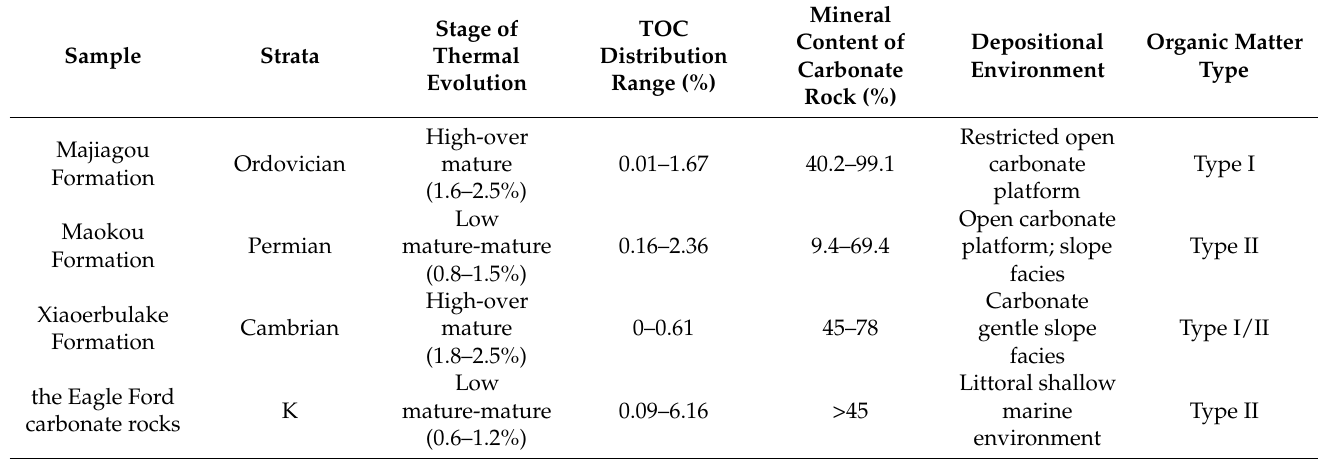
Table 2. Basic information on the studied carbonate source rock samples